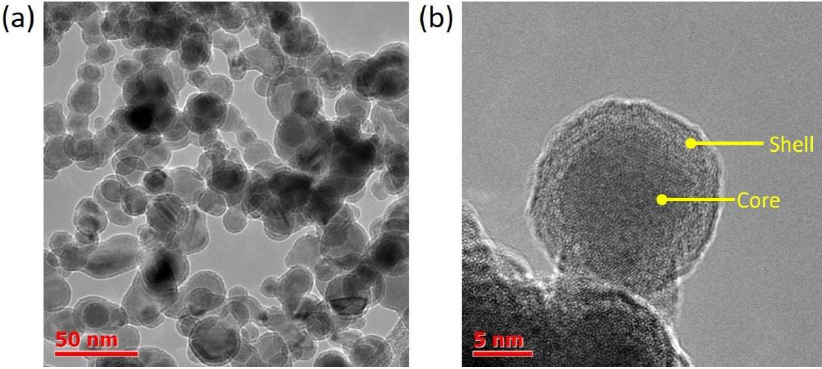
Figure 1. Representative TEM images of Fe@C particles: ( a ) overview and ( b ) close-up view.